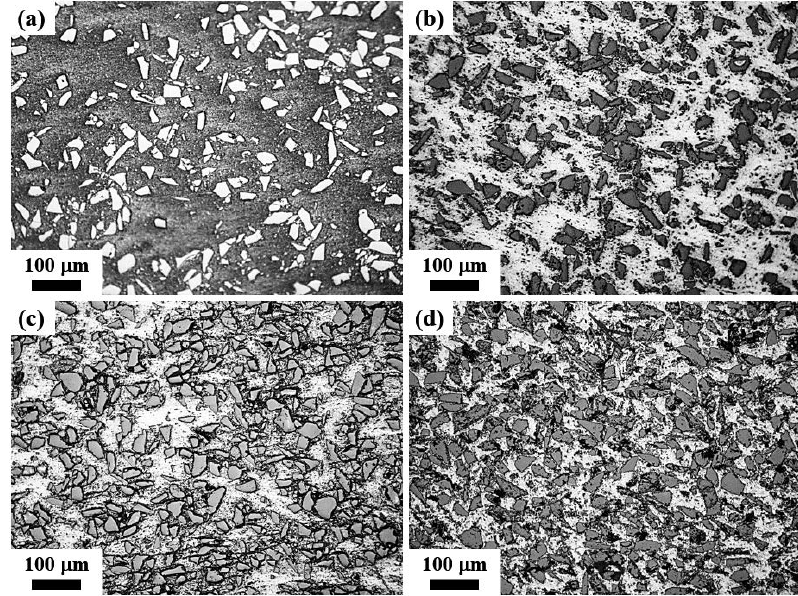
Figure 7. Optical microscope images of the SiC/6061Al composites produced by the NISFAC process in quantities of 500 g (a,b) and 1000 g (c,d) .